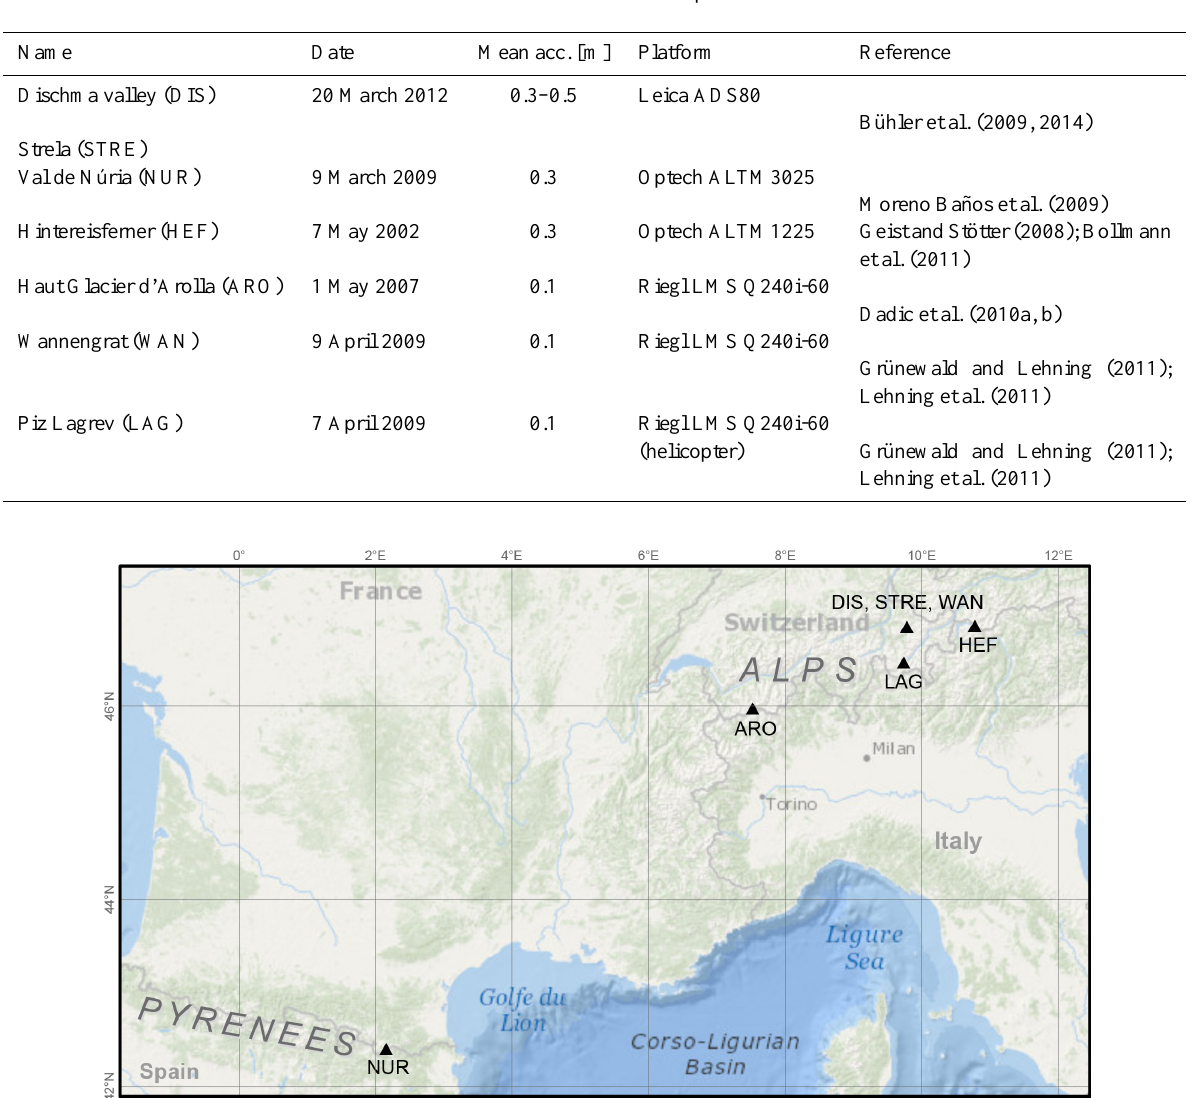
Table 1. Data sets analysed in the study where “Date” refers to the date of the winter survey, “Mean acc.” to the mean accuracy in vertical direction as denoted in the reference column and “Platform” to the measurement platform.